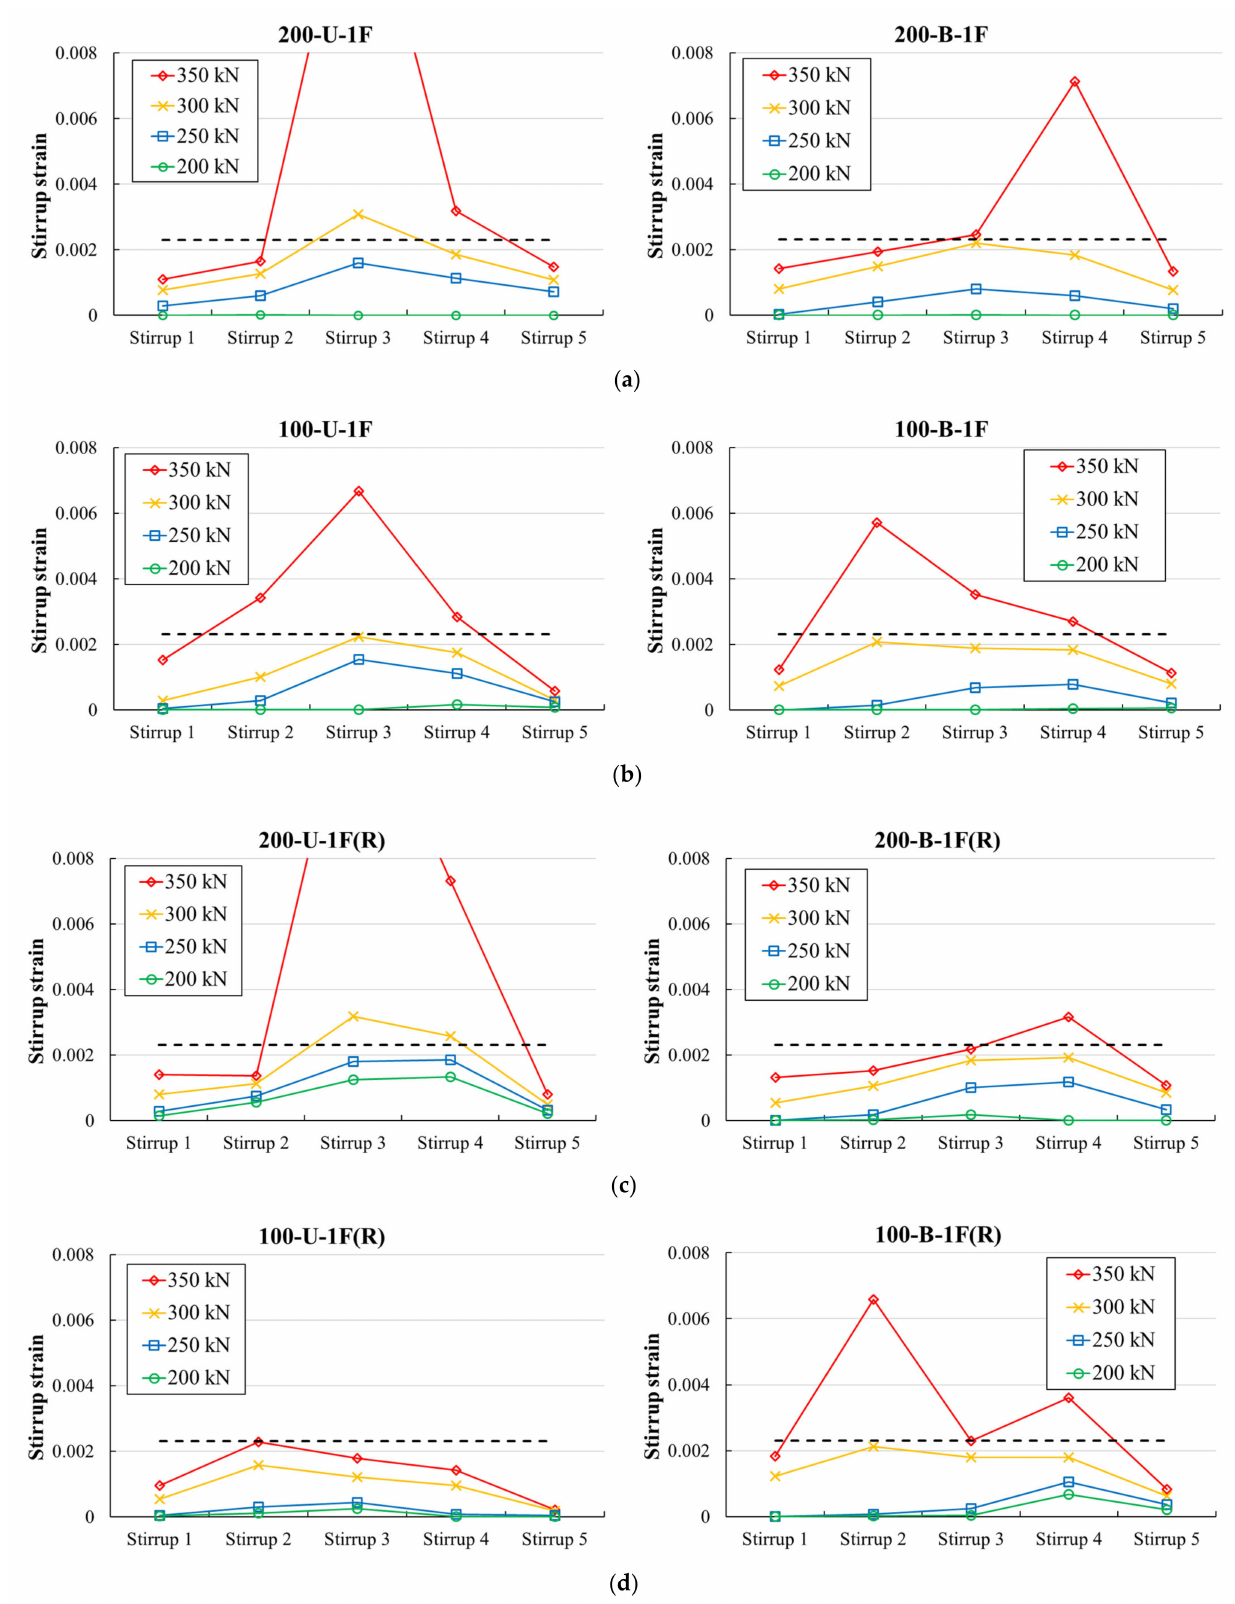
Figure 10. Measured stirrup strains of first series of specimens: ( a ) 200 mm spacing; ( b ) 100 mm spacing; ( c ) 200 mm spacing—repaired; ( d ) 100 mm